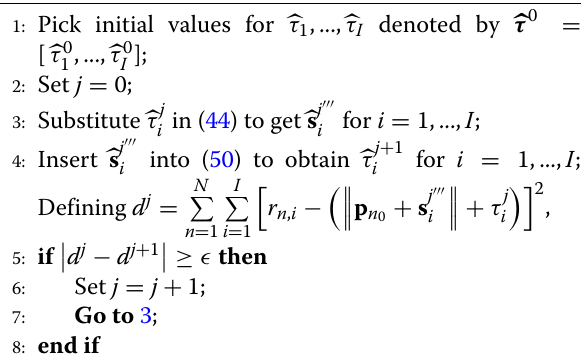
Algorithm 2 may be suboptimal. A more granular initial- ization range for the parameter θ increases the chance of finding the global optimum rather than a local optimum. Algorithm 2 Iterative approach to approximation